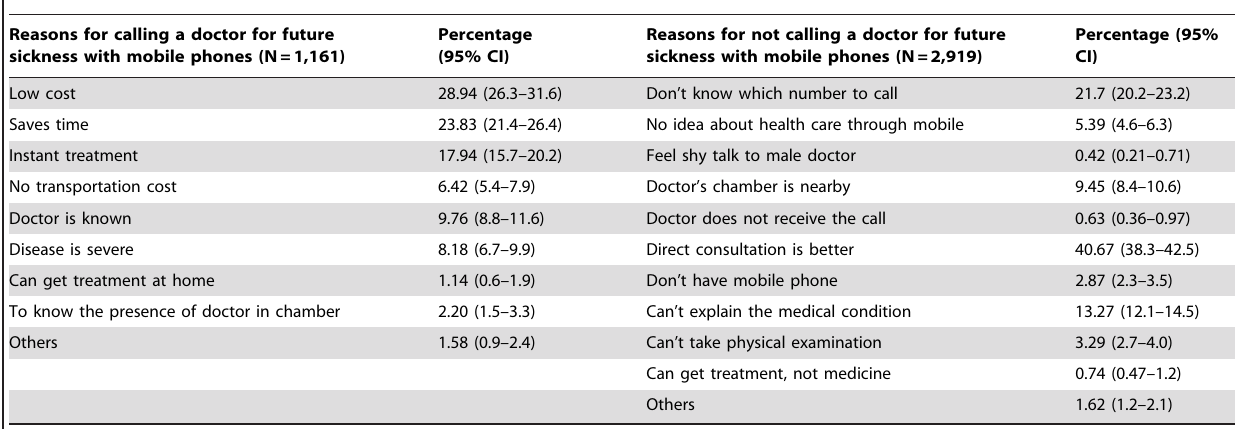
Table 9. Reasons for calling/not calling doctor for future sickness with mobile phones (First answer reported).